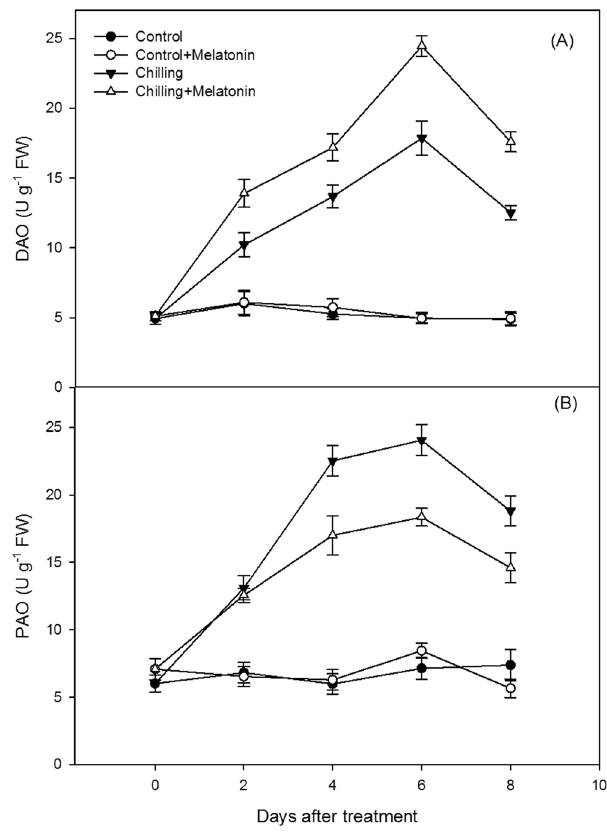
Figure 5. Effects of exogenous melatonin on polyamine degradation enzyme activities assay under chilling stress. ( A ) Diamine oxidase (DAO), ( B ) polyamine oxidase (PAO). Control, treating at 28/18 °C; Control + Melatonin, pre-treating with 200 μ M melatonin and treating at 28/18 °C; Chilling, treating at 15/8 °C; Chilling + Melatonin, pre-treating with 200 μ M melatonin and treating at 15/8 °C; Date represent means ± SD of third replicate samples.